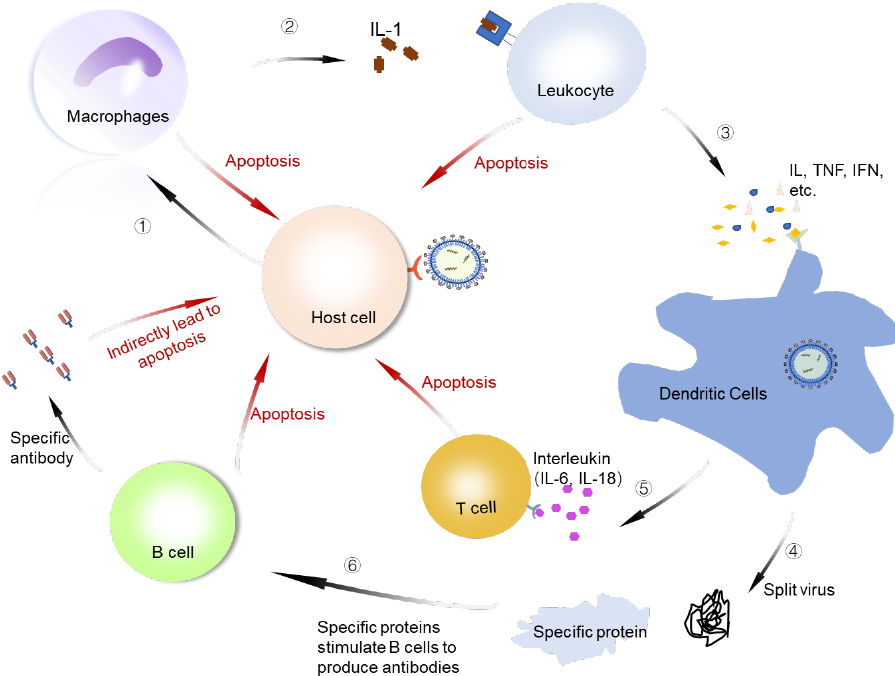
Figure 5. Schematic representation of cytokine storm. ① A large number of viruses infect host cells and stimulate macrophages to fight the virus. ② Phagocytes can secrete cytokines to attract white blood cells to inhibit SARS-CoV-2. ③ Leukocytes secrete specific cytokines to stimulate cell pathways to attract the arrival of dendritic cells to reduce the number of viruses. ④ Dendritic cells degrade the virus into specific proteins and nucleic acids. ⑤ Dendritic cells also secrete IL-12 and IL-18, which activate signal molecules to stimulate T-cell proliferation and enhance immune effects. ⑥ Virus-specific proteins and nucleic acids induce B cells to differentiate into effector B cells that can secrete specific antibodies to fight the virus. IL: interleukin; IFN: interferon; TNF: tumor necrosis factor.